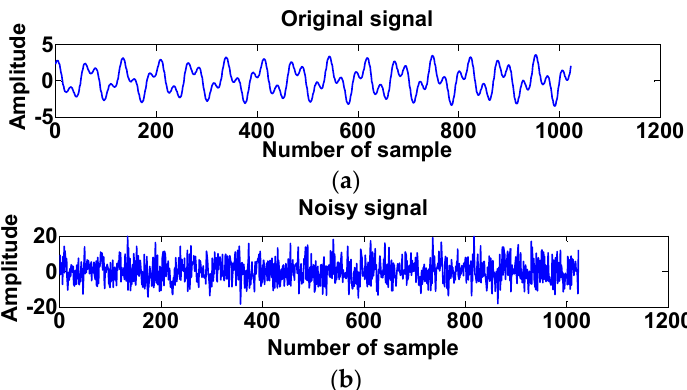
Figure 3. The time ‐ domain waveform of the original signal and noisy signal. This paper uses white Gaussian noise to simulate the truthful noise of the vibration environment. ( a ) Pure signal; ( b ) Noisy signal. Appl. Sci. 2016 , 6 , 154